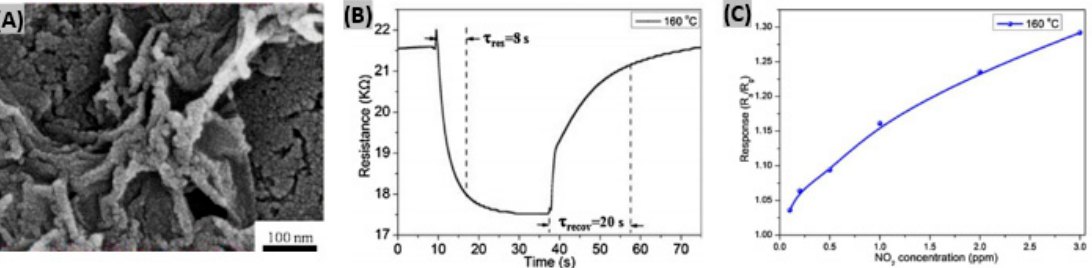
Figure 6. ( A ) High magnification SEM images of the fabricated MoS 2 -RGO hybrids. ( B ) Response- recovery curve of MoS 2 -RGO sensor to 3 ppm NO 2 at 160 °C. ( C ) Sensor responses to different NO 2 concentrations at 160 °C. Figures adapted with permission from [102], Copyright 2017 Elsevier.